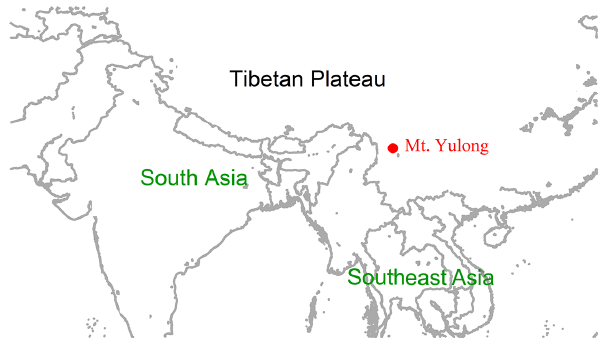
Figure 1. The location of the sampling site at Mt. Yulong (27.2 ◦ N, 100.2 ◦ E;